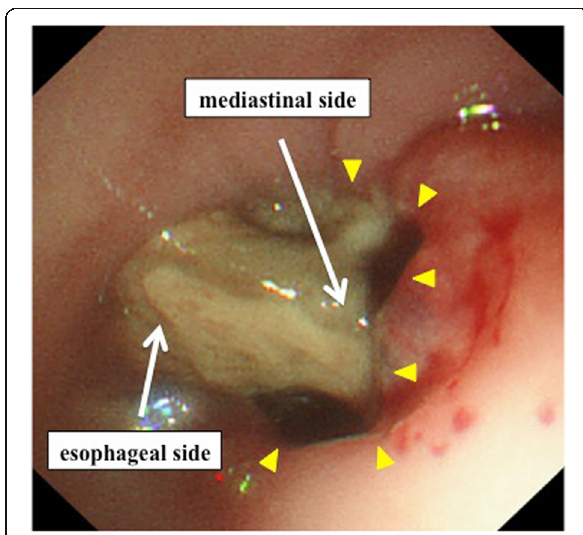
Fig. 2 Endoscopy revealed perforation ( arrowhead ) on the right wall of the middle thoracic esophagus 32 – 35 cm distant from the incisors.